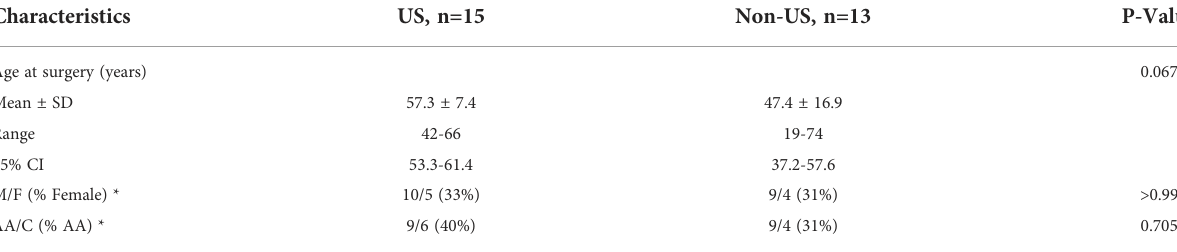
TABLE 1 Baseline Characteristics and Presenting